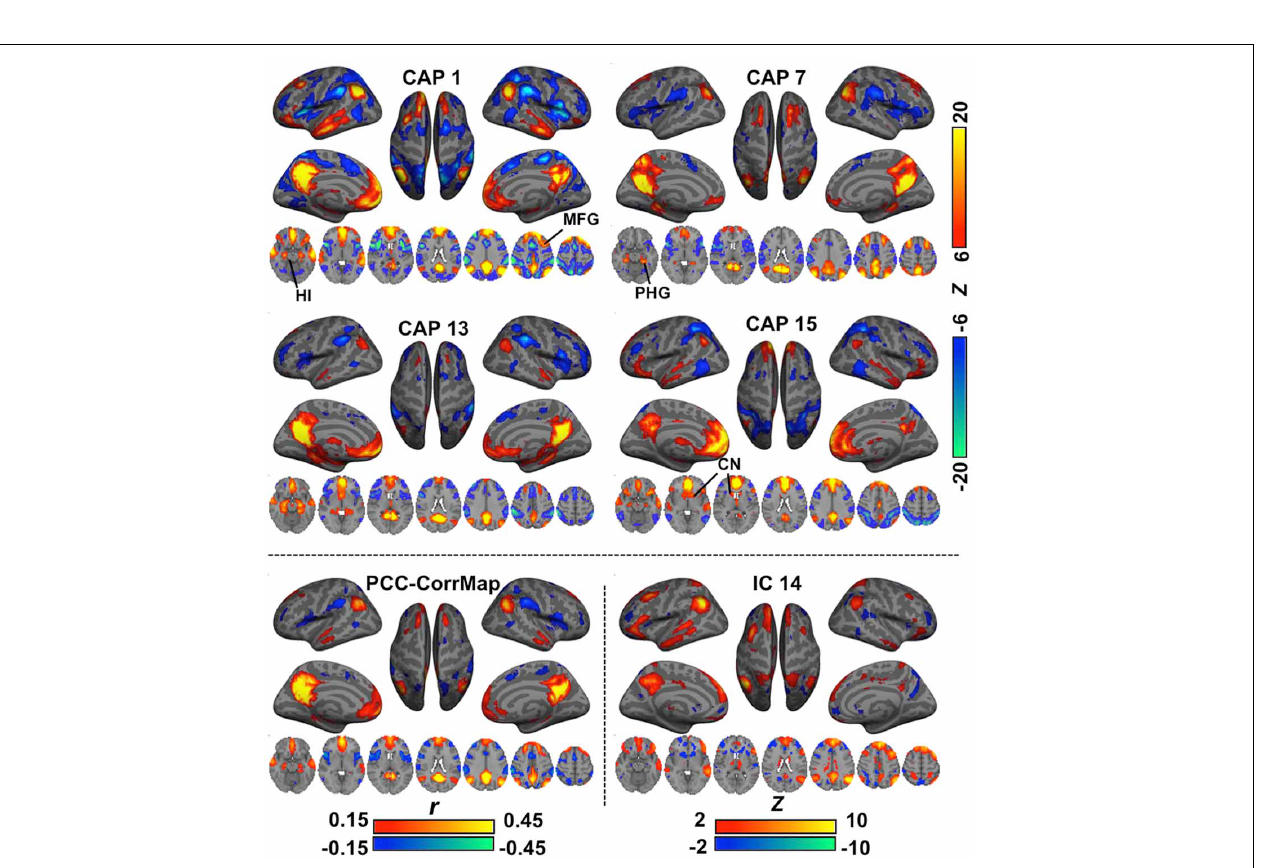
represents signal from the PCC seed region (green square). Small structures indicated by white arrows are the hippocampus (HI) and posterior parahippocampal gyrus (PHG) in T11 and the ventral lateral nucleus (VL) in T3. The color bar represents normalized BOLD signal for the sample frames and correlation values for the seed-based correlation map.